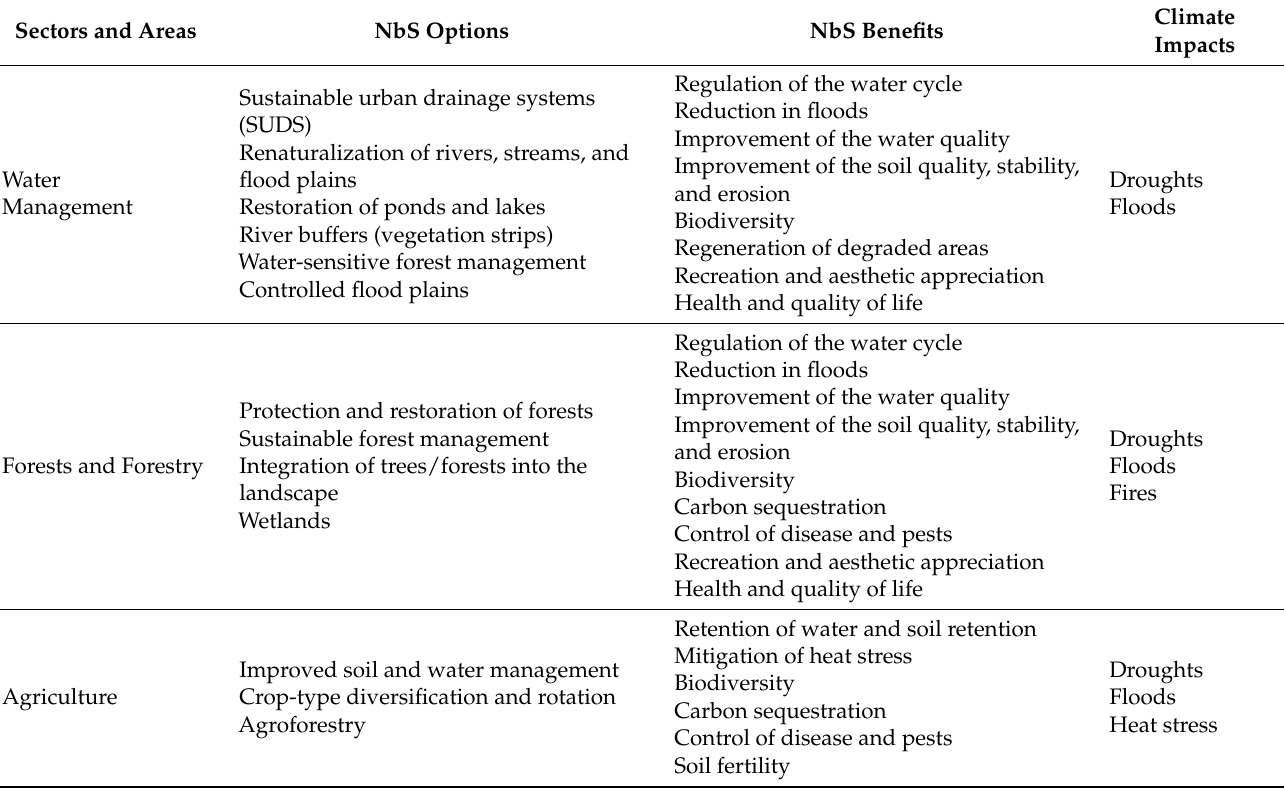
Table 1. Benefits of nature-based solutions to address climate risks in specific sectors and thematic areas. Sectors and